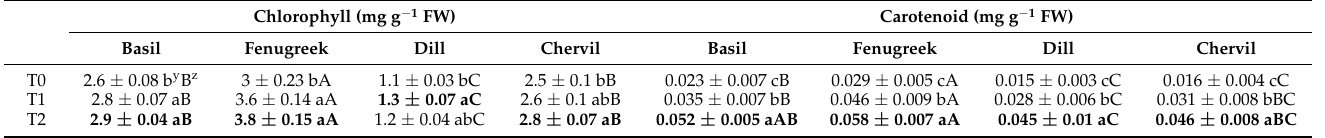
Table 4. Chlorophyll and carotenoid contents (mg g − 1 FW) of basil, fenugreek, dill, and chervil microgreens cultivated under three light-emitting diode (LED) lamp spectra. The best light treatment, for each plant species, is